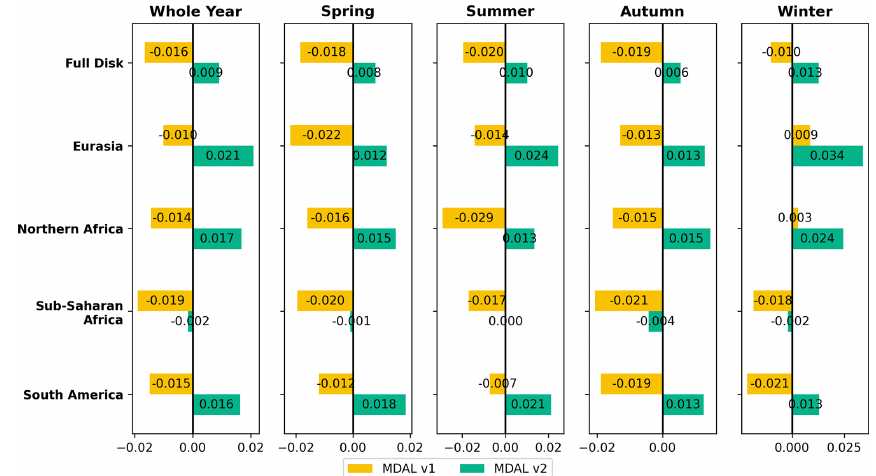
Figure A4. Mean MBE with regard to ETAL by region and season (AL-BB-DH; season names referring to season months of the